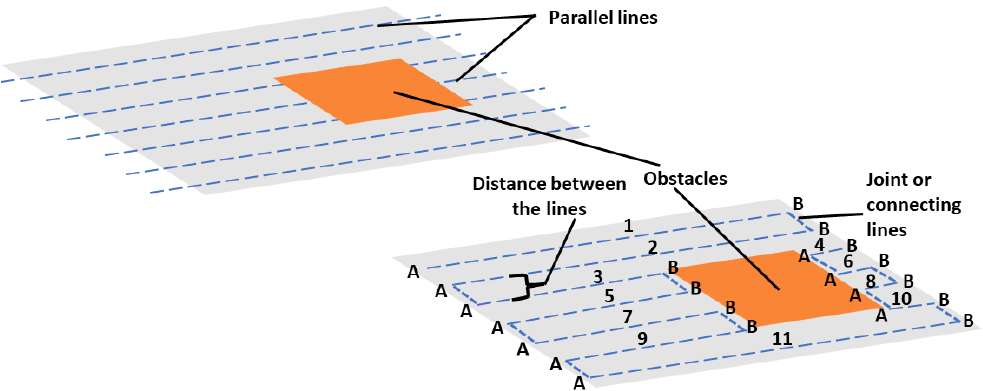
Figure 5. Coverage Path Generation illustrating the parallel ad connecting lines ( top ) along with the segmentation part ( bottom